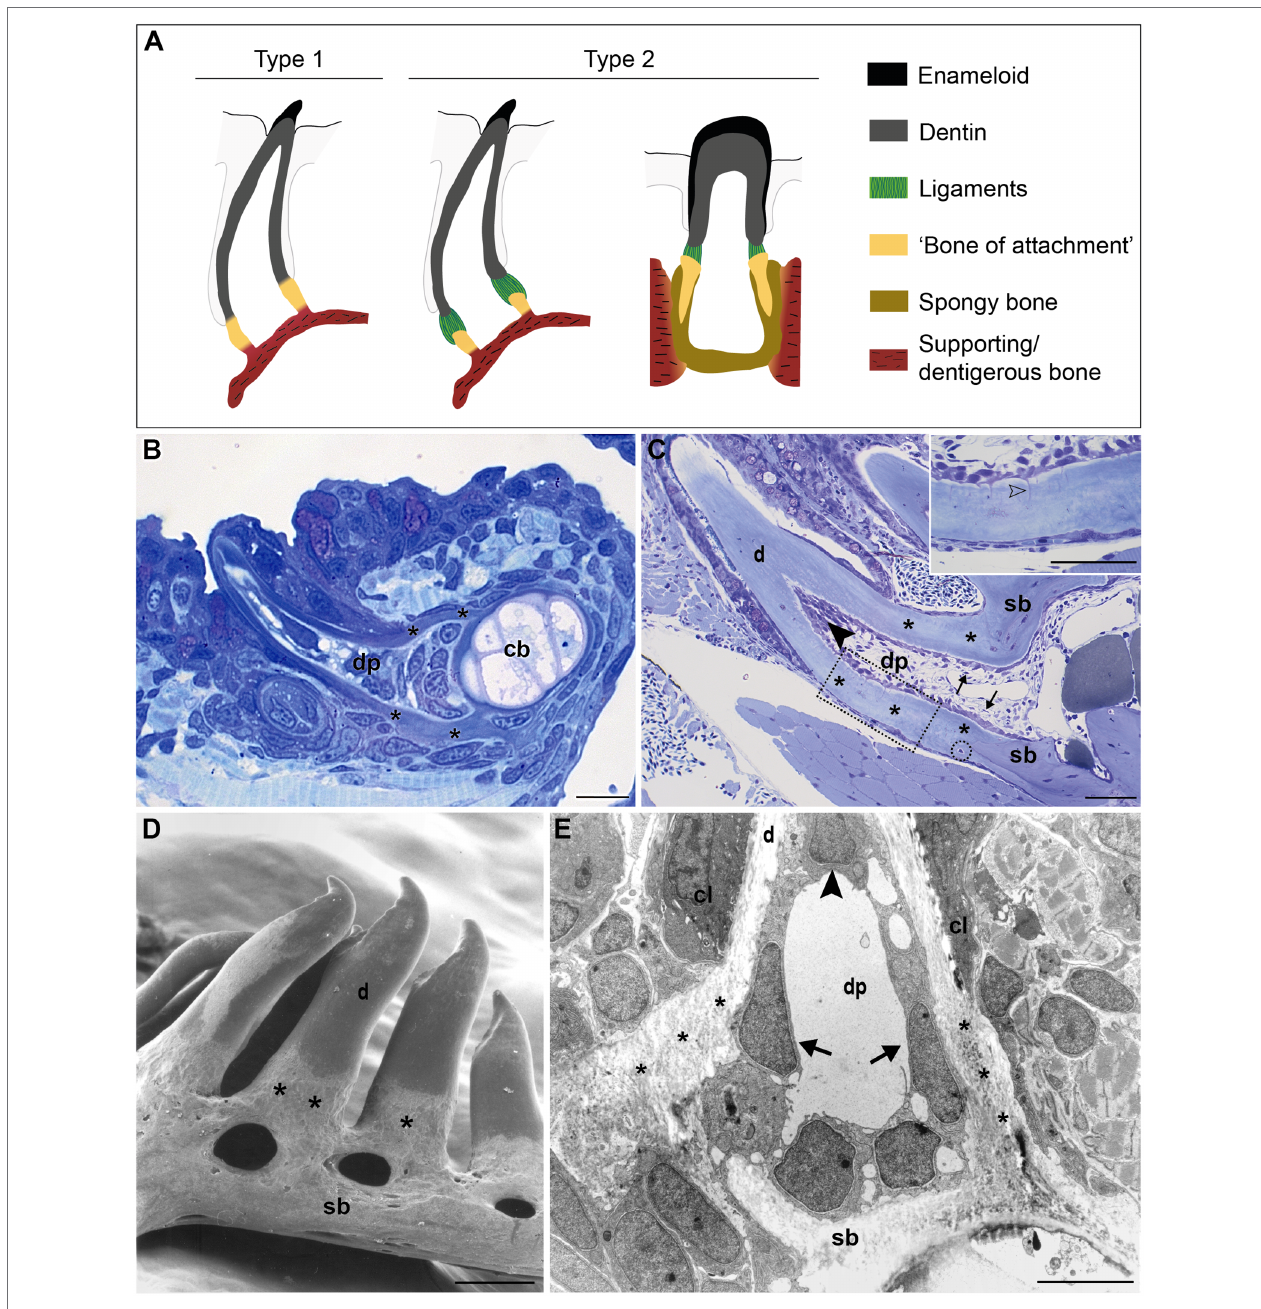
FIGURE 1 | Tooth attachment in actinopterygians. (A) Schematic representation of type 1 and type 2 tooth attachment modes according to Fink (1981). In type 1 (e.g., zebrafish), a cylindrical collar of tissue, hitherto called “bone of attachment” (“attachment bone” in the terminology of Fink, 1981), firmly ankyloses the tooth to the supporting bone, resulting in continuous mineralization between the tooth base and the supporting (dentigerous) bone. In type 2, the cylindrical collar of “bone of attachment” is connected to the tooth by a ligament. The collar is positioned either on top, or inserted into the supporting bone. Note that in the latter case, Berkovitz and Shellis (2016) label the “bone of attachment” as “pedicel”, reserving the term “bone of attachment” for the tissue serving to attach the pedicels. Note that the term “bone of attachment” is used between quotation marks, pending a more appropriate term based on the findings in this study. (B) and (C) Toluidine blue-stained semi-thin sections of a zebrafish initiator tooth at 6 dph (B) and an adult tooth (C) , both attached, as in type 1 attachment. Note multiple osteocytes in the adult supporting bone, a single one in the “bone of attachment” (encircled). Inset: enlargement of “bone of attachment” (dotted rectangle) with cell prolongations (open arrowhead). (D) Scanning electron micrograph of attached adult zebrafish teeth. (E) Overview transmission electron microscopy (TEM) picture of the base of a zebrafish first-generation tooth at the level of the cervical loop. The dentin, “bone of attachment” and supporting bone form a continuous mineralized tissue, covered along the pulpal side with scleroblasts that appear to be involved in the deposition of more than one matrix. cb, ceratobranchial cartilage; cl, cervical loop; d, dentin; dp, dental pulp; sb, supporting bone; asterisks, “bone of attachment”; arrows, scleroblasts forming “bone of attachment”; black arrowheads, odontoblasts. Scale bar (B) = 10 μ m, (C) = 50 μ m, (D) = 100 μ m, and (E) = 5 μ